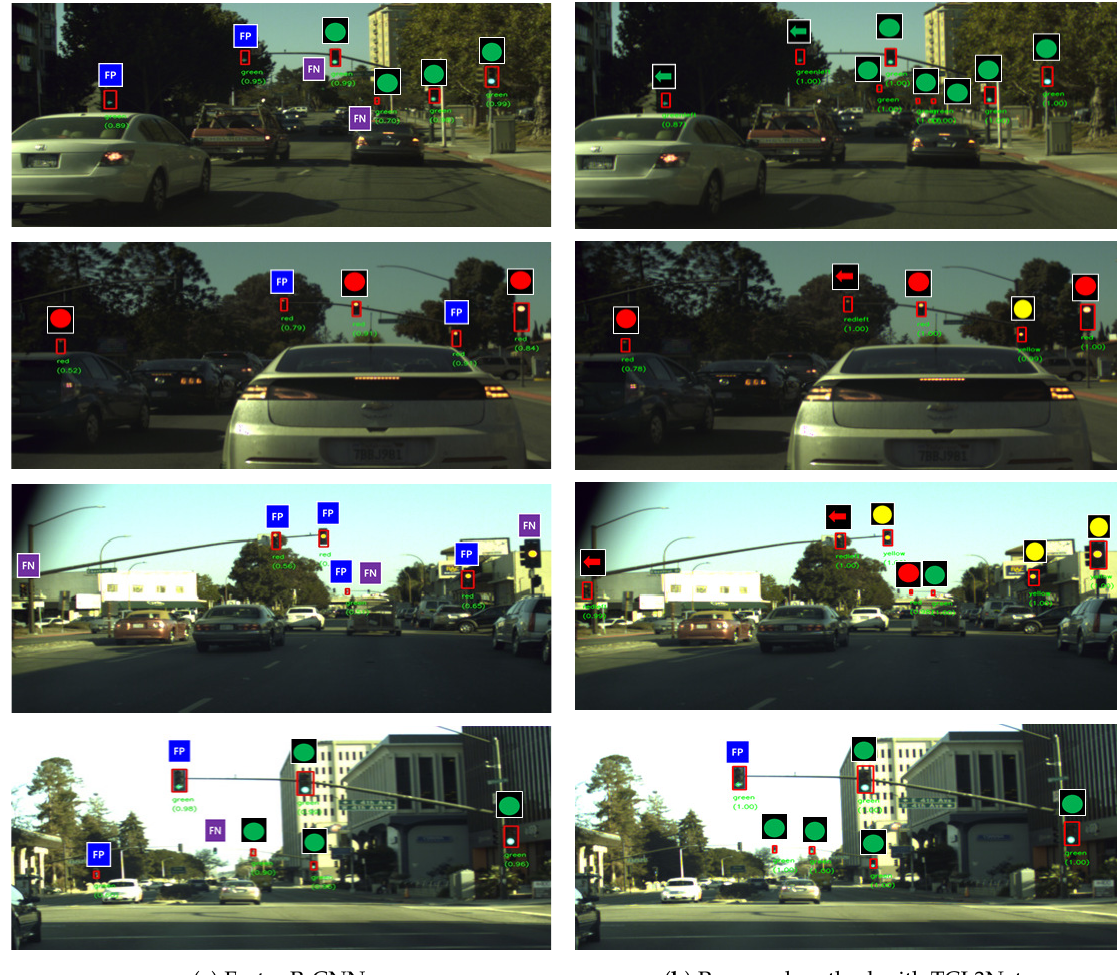
Figure 5. TL recognition examples of the Faster R-CNN and the proposed